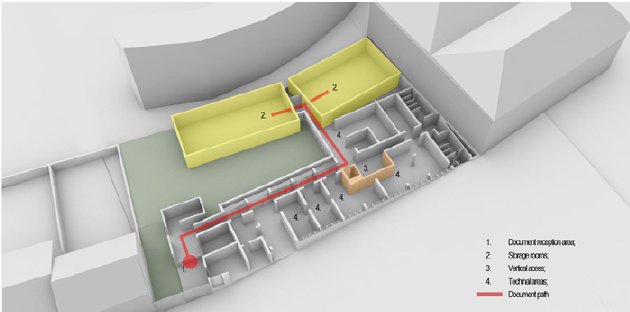
Figure 11. Proposed ground floor in Abade